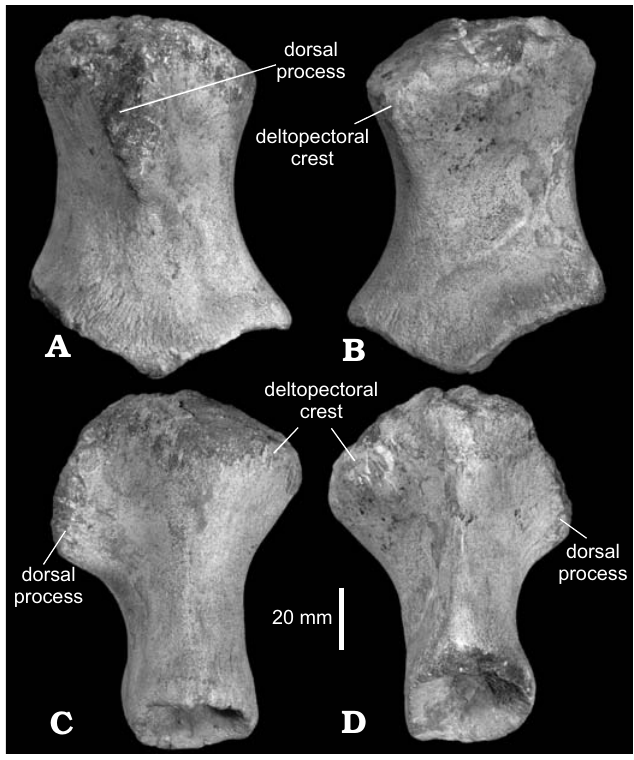
Fig. 8. Right humerus of ophthalmosaurid ichthyosaur Cryopterygius kielanae sp. nov. (GMUL 3579-81, holotype) from the Late Jurassic of Owadów-Brzezinki Quarry; in dorsal ( A ), ventral ( B ), anterior ( C ), and posterior ( D )